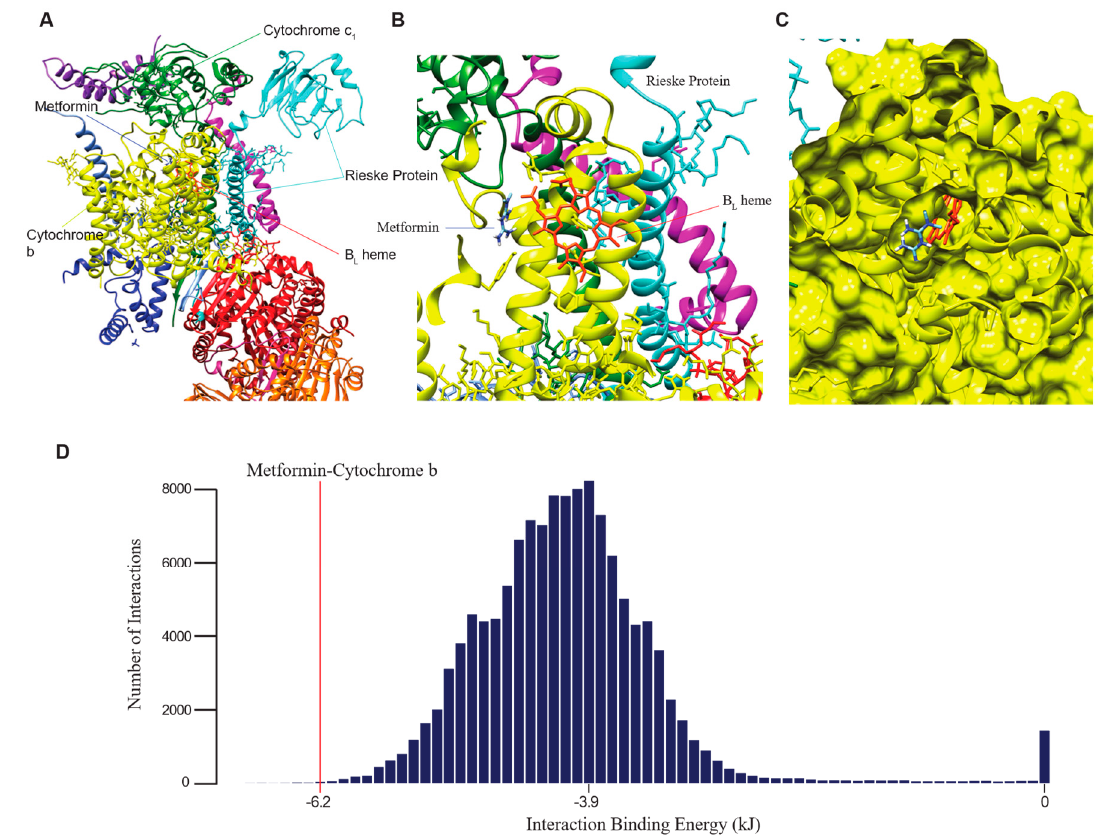
Figure 3. Computational prediction of complex III binding to metformin. ( A ). Broad-angle screenshot of UCSF Chimera’s visualization of metformin’s position of binding within complex III that is predicted to have the lowest energy. ( B ). Magnified view of metformin binding position. ( C ). Molecular surface visualization positions metformin within the same pocket as the B L heme when it binds to complex III. ( D ). Plot of number of interactions vs. interaction energy of AutoDock Vina’s virtual screening of metformin’s interaction with 127,635 potential binding pockets on 250 proteins and their associated complexes. The red line indicates the predicted binding energy of metformin to the Q o site of cytochrome b at − 6.2 kJ.